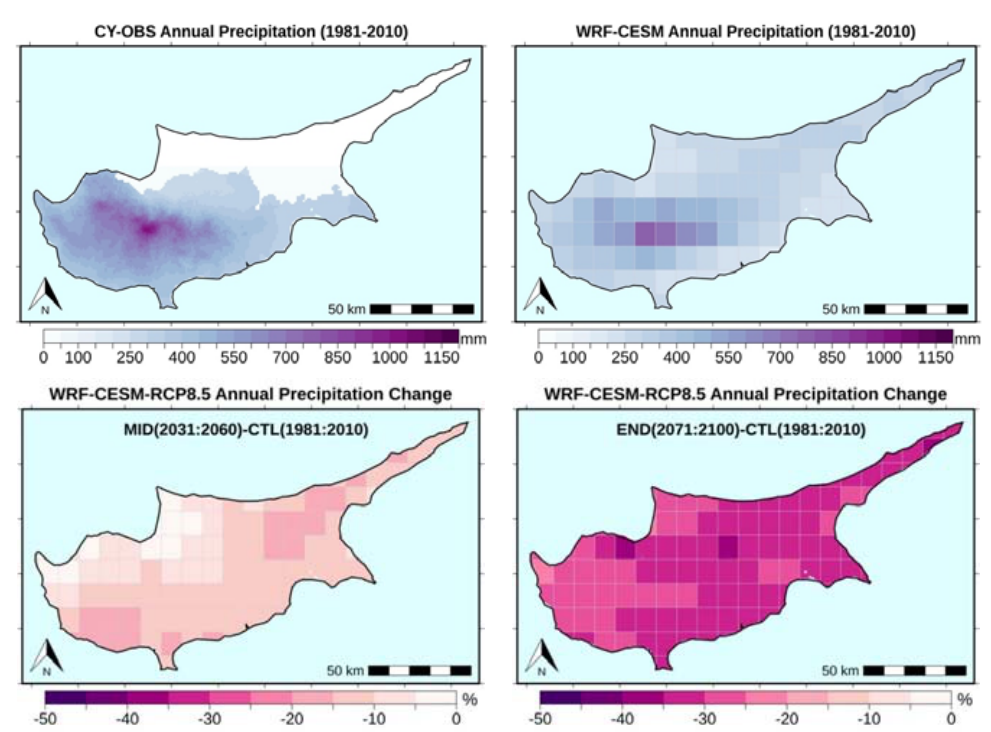
Figure 2. Observed ( top left ) and simulated ( top right ) annual precipitation total for the period 1981 to 2010 and projected changes for the middle ( bottom left ) and end of the 21st century ( bottom right ).